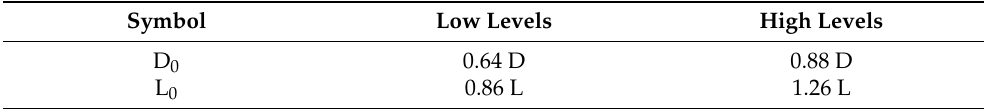
Table 2. Response surface design levels.